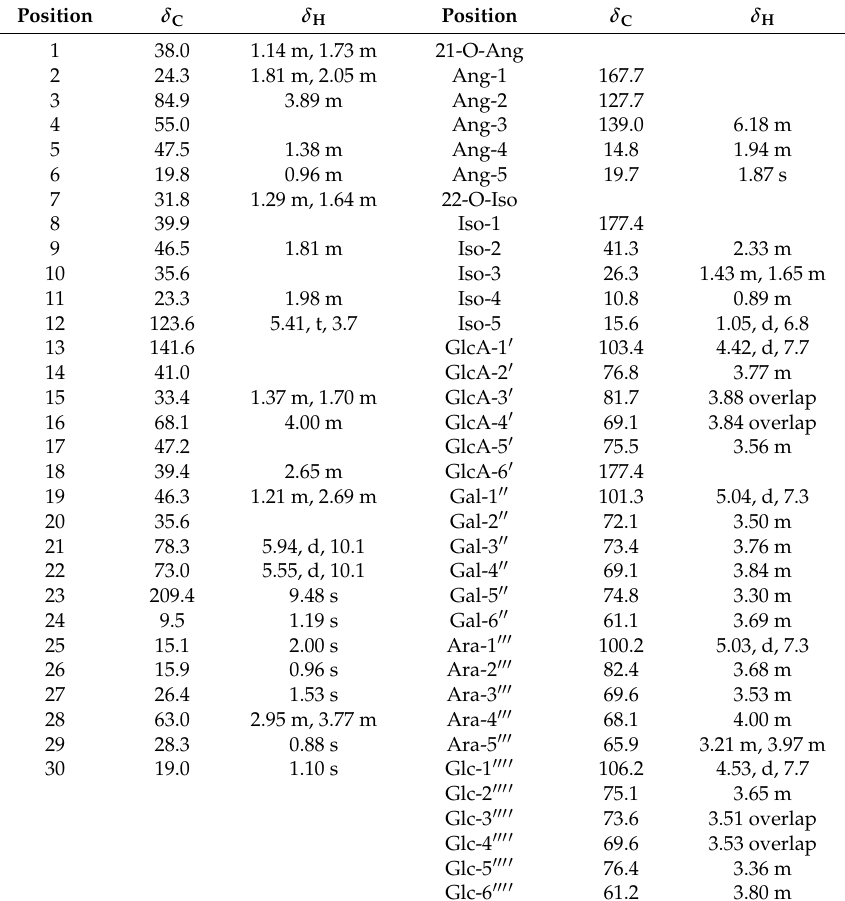
Table 1. NMR spectroscopic data for oleiferasaponin A 2 (in methanol- d 4 ).